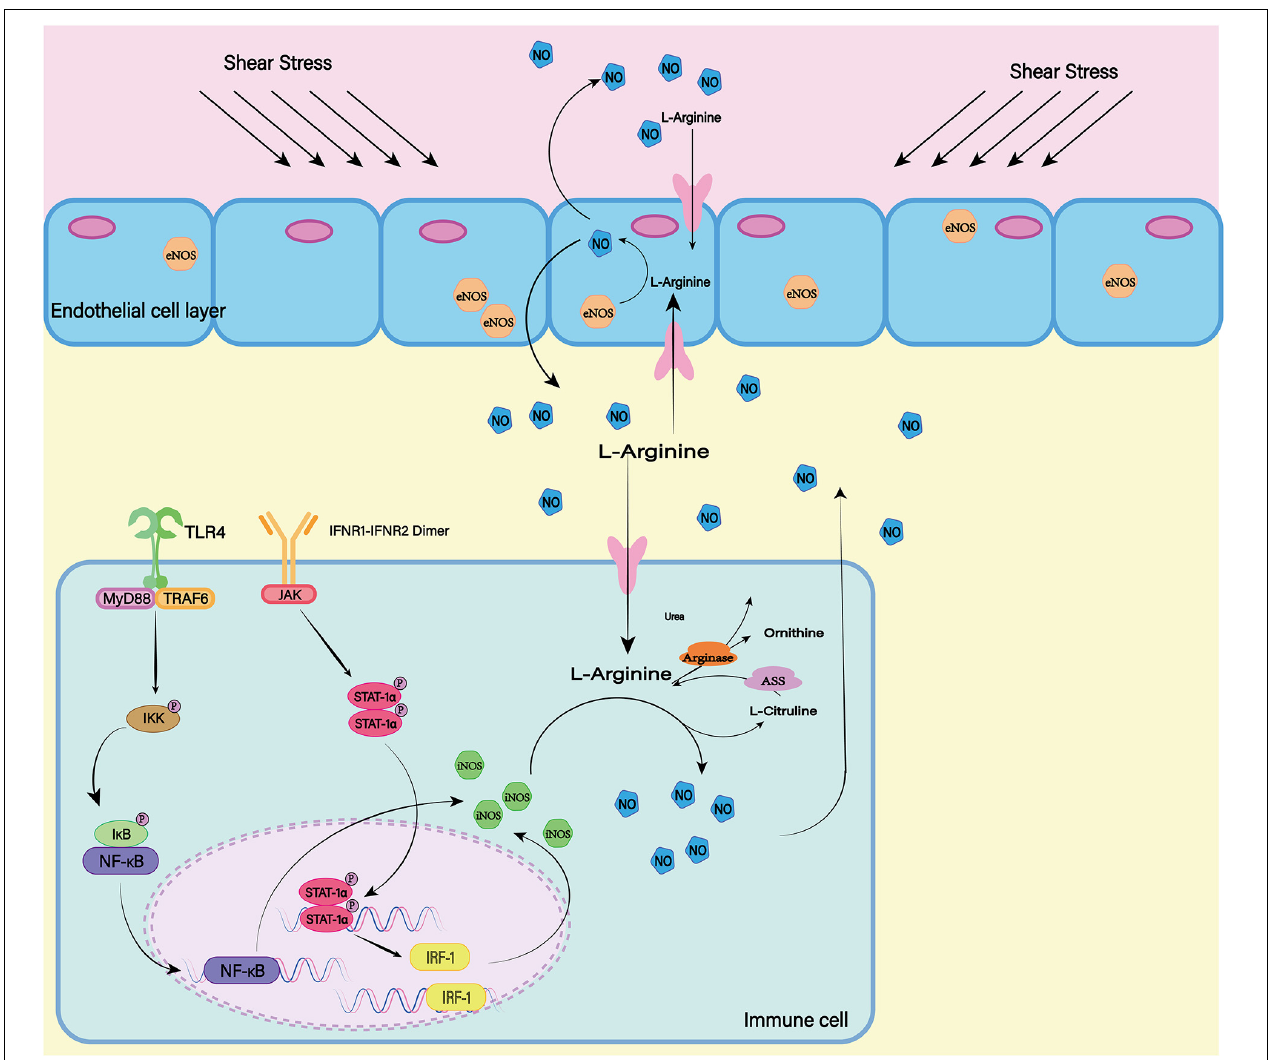
FIGURE 6 | In mammals, there are three isotypes of nitric oxide synthase (NOS) (eNOS, iNOS, and nNOS). ENOS is the most important source of NO in endothelial cells. The shear stress of blood flow on the vascular wall is the main mechanism by which eNOS produces NO. INOS can be induced in a variety of cell types. LPS as a proinflammatory medium can induce the expression of iNOS. At the same time, the transcription factors NF- κ B and STAT-1 α are believed to be necessary for iNOS transcription in most cells. nNOS is highly expressed mainly in peripheral nerve fibers and is thought to have a protective effect on atherosclerosis. The release of L-Glutamate (L-Glu) from baroreceptors activates nNOS and promotes the production of NO. Although the expression mechanisms of the three isotypes are different, all of them can generate NO and L-Citrulline (L-CCP) as the substrate.